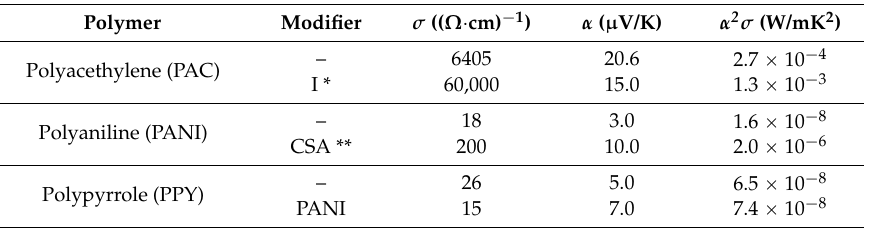
Table 3. The thermoelectric parameters of the selected electroactive polymers. Polymer